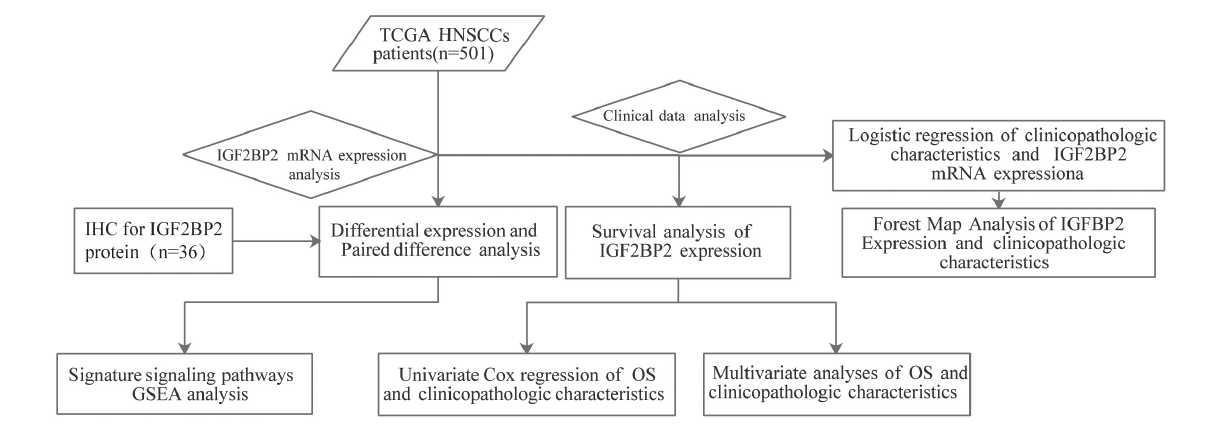
FIGURE 1 | Workflow graph for this